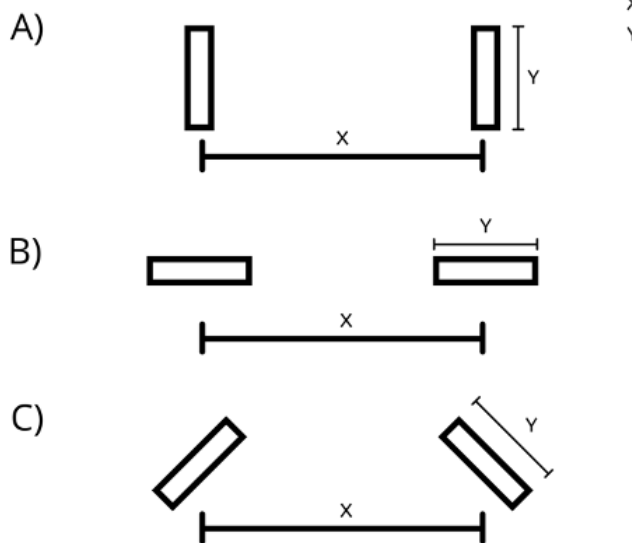
Figure 2. Handle orientations: ( A ) vertical, ( B ) horizontal, and ( C ) semi-pronated included in the handle designs. Interhandle distance (X) between the two handles was a distance of 40.0 cm, and the length of the handle (Y) itself was 14.0 cm.